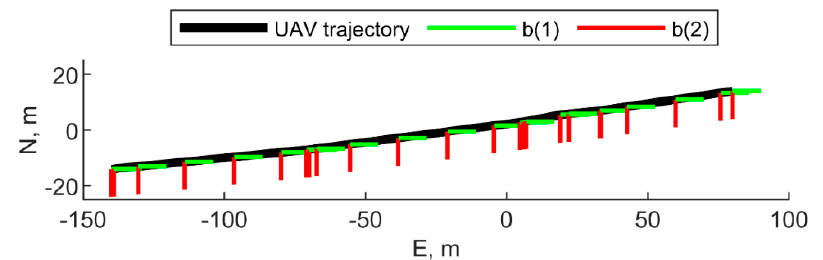
Figure 3. Trajectory of the chief vehicle in NED, top view. The heading angle is assumed to be equal to 90 ◦ , i.e., the vehicle is pointing eastward. The first and the second axes of the BRF are reported in the figure in green and red, respectively. UAV altitude is 20 m.